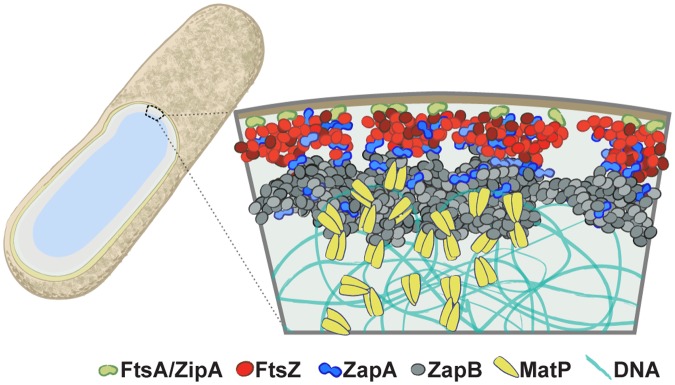
The multi-layered organization of the E. coli divisome.A schematic illustrating the relative radial arrangement of FtsA/ZipA-FtsZ-ZapA-ZapB-MatP. FtsA (green) and ZipA (orange) tether the punctuate FtsZ (red) structure to the inner membrane. ZapA (blue) mimics FtsZ but can deviate, possibly by interacting with ZapB or a number of membrane proteins [50,51]. The large, internal ZapB (grey) structure indirectly associates with FtsZ through ZapA, and is anchored on the chromosome through its associations with MatP (yellow).